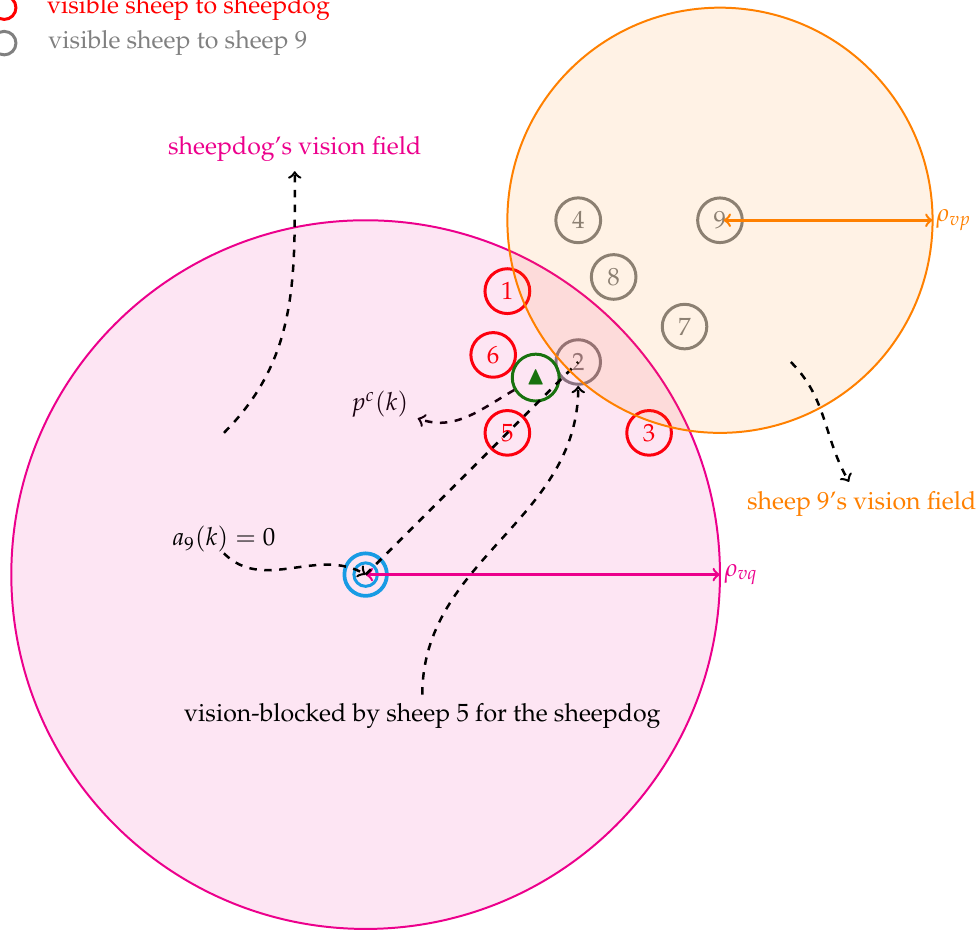
Figure 3. An example of the visual fields of sheep and